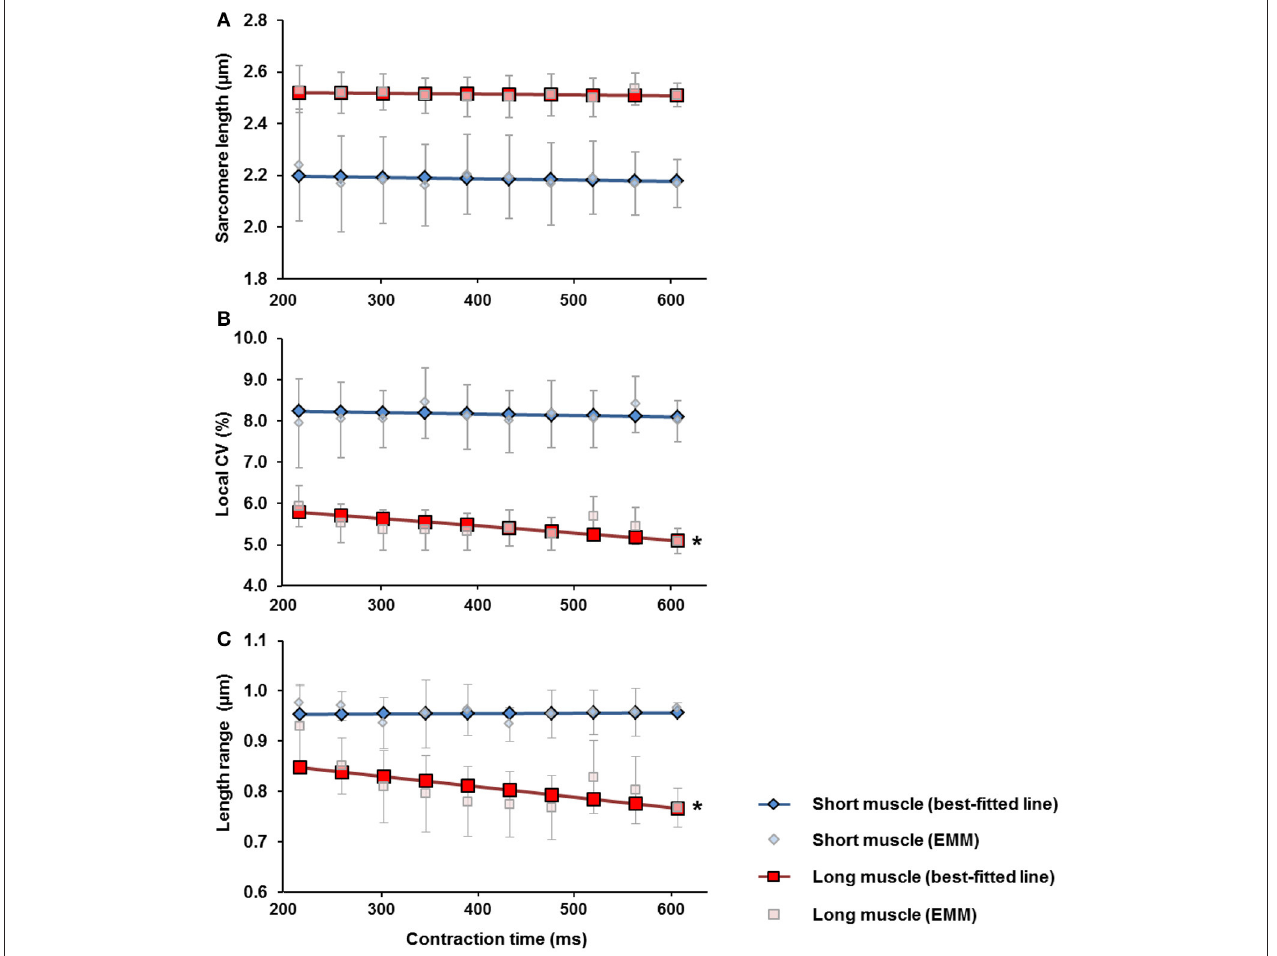
FIGURE 5 | Changes of (A) the mean sarcomere length (SLs), (B) the local coefficient of variation (CV) of SLs and, (C) the SL range, over the 600ms contraction period measured at the short (blue diamonds) and the long (red squares) muscle lengths. For both muscle lengths, the mean SLs remained constant throughout the contraction period. For the short muscle, the local CV and SL range stayed constant during the 600ms contraction period. For the long muscle, the local CV and the SL range decreased by ∼ 12% and ∼ 9%, respectively throughout the 600ms contraction period. *Indicates significant relationship between contraction time and local CV, as well as between contraction time and SL range ( p < 0.05). EMM-estimated marginal